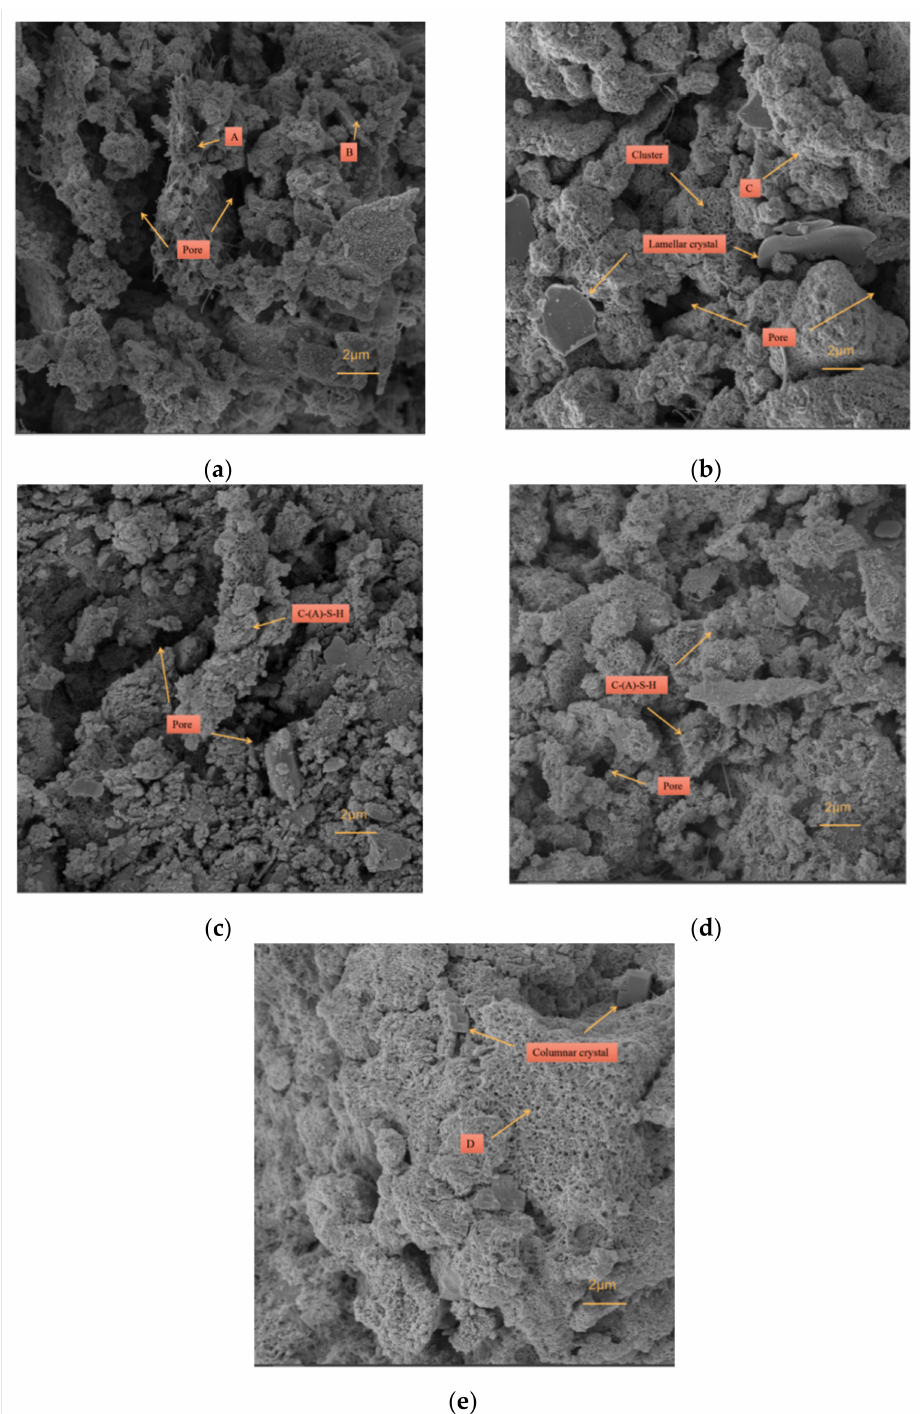
Figure 12. SEM results of CPB samples with the optimal mix ratios at different ages: ( a ) 1 day, ( b ) 3 days, ( c ) 7 days, ( d ) 14 days, and ( e ) 28